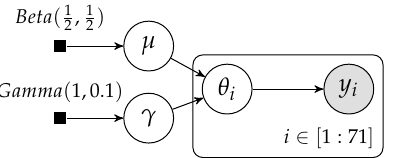
Figure 5. Reinterpreted hierarchical graphical model for the rodents example.